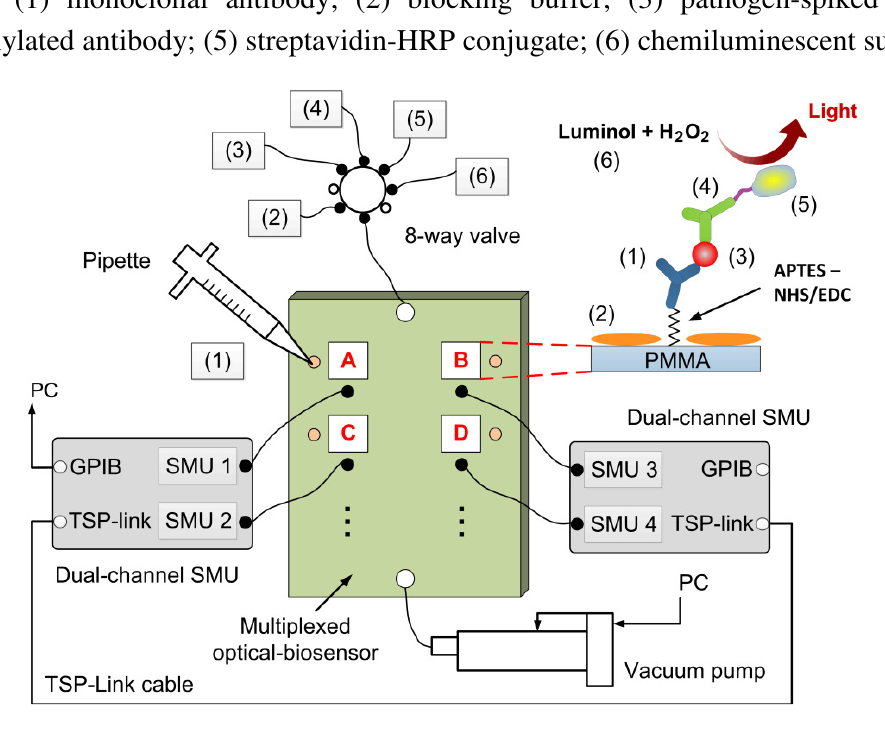
Figure 2. Schematic diagram of the experimental setup for the multiplexed pathogen detection. Four detection zones (A–D, chamber + OPD) were monitored using two multi-channel SMUs, and chemiluminescent immunoassays were performed following the protocol: (1) monoclonal antibody; (2) blocking buffer; (3) pathogen-spiked